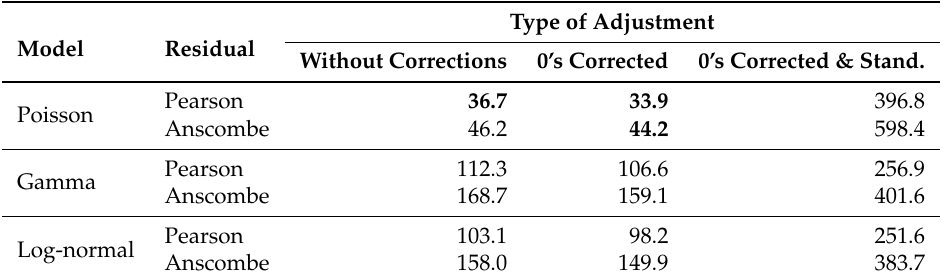
Table 11. Model validation using the Dawid–Sebastiani scoring rule (DSS). The three lowest scores are indicated in